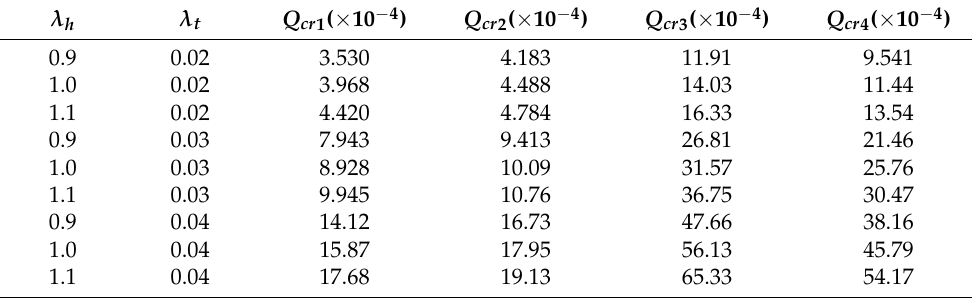
Table 2. Four critical loads under different λ h and λ t ( β = 0 ).